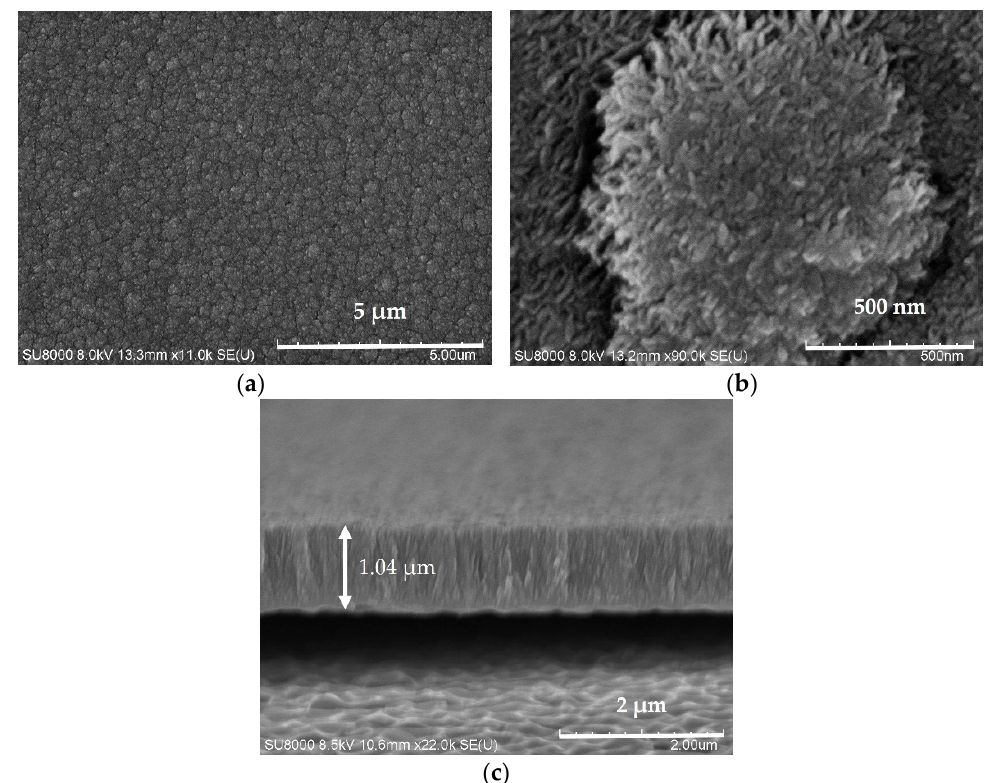
Figure 8. SEM micrographs of the surface and cross-sectional morphology of the MoS 2 films deposited on PDMS substrates at the power of 350 W; ( a , b ) lower and higher magnifications, respectively; ( c ) the cross-sectional image of sputtered MoS 2 film.